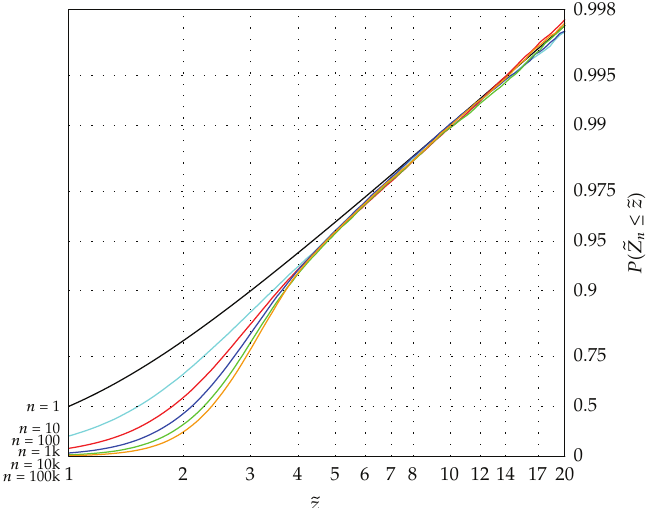
(cid:20) Z n ≤ (cid:20) z (cid:3) that is close to 1 as 1 − P